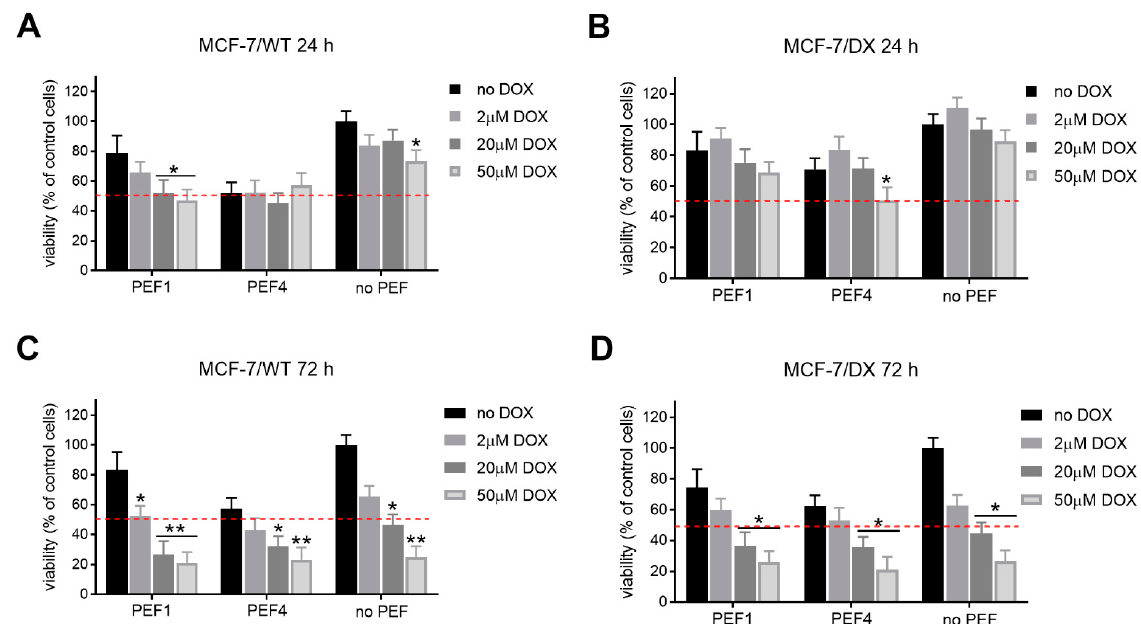
Figure 5. The viability of cells exposed to electrical pulses without (no DOX) and with doxorubicin C DOX = 2, 20 or 50 µ M) after 24 h for MCF-7/WT ( A ) and MCF-7/DX ( B ) cells; 72 h for MCF-7/WT ( C ) (DOX, C DOX = 2, 20 or 50 μ M) after 24 h for MCF ‐ 7/WT ( A ) and MCF ‐ 7/DX ( B ) cells; 72 h for MCF ‐ and MCF-7/DX ( D ). The following treatment protocols were used: PEF1—10 kV/cm × 300 ns × 200; 7/WT ( C ) and MCF ‐ 7/DX ( D ). The following treatment protocols were used: PEF1—10 kV/cm × 300 PEF4—1.2 kV/cm × 100 µ s × 8 (ESOPE). All the data are normalized to untreated control. Asterisk (*) ns x 200; PEF4—1.2 kV/cm x 100 μ s × 8 (ESOPE). All the data are normalized to untreated control. corresponds to ( p < 0.05) or (**) to ( p < 0.005) statistically significant